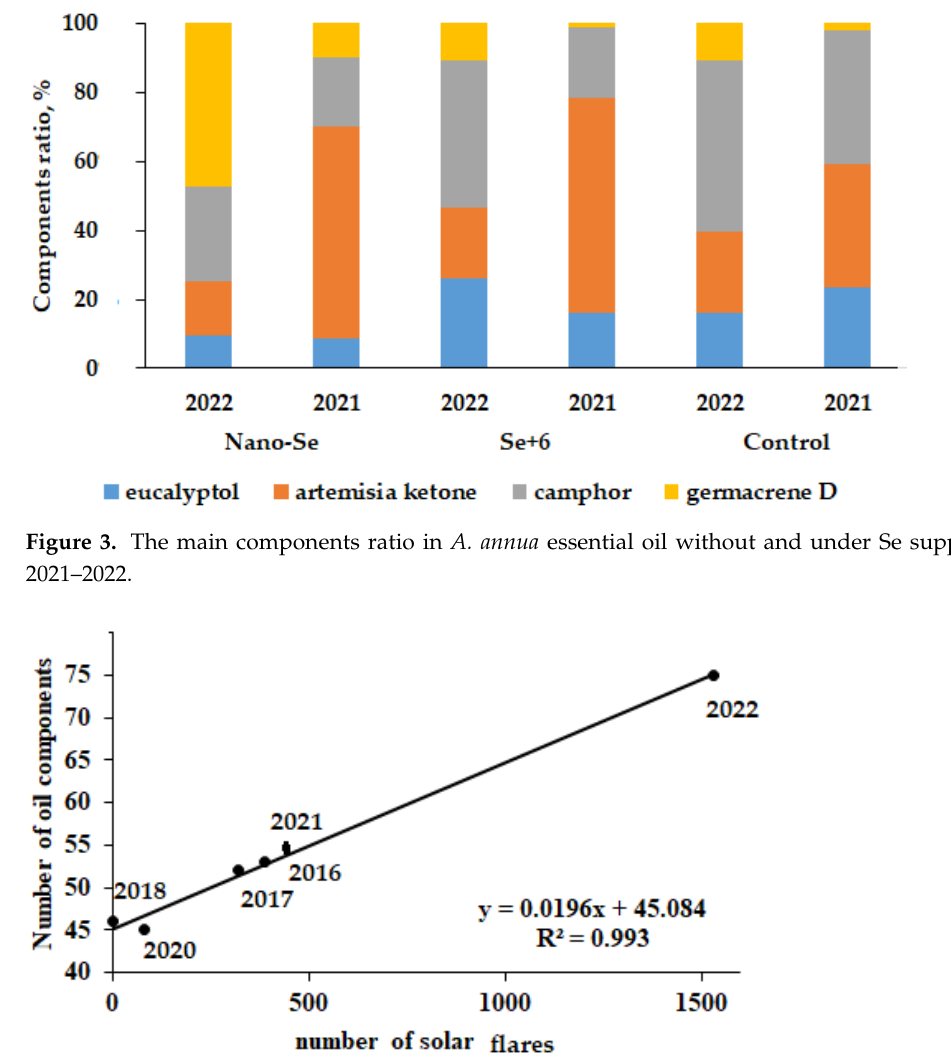
Figure 3. The main components ratio in A. annua essential oil without and under Se supply in 2021– 2022.